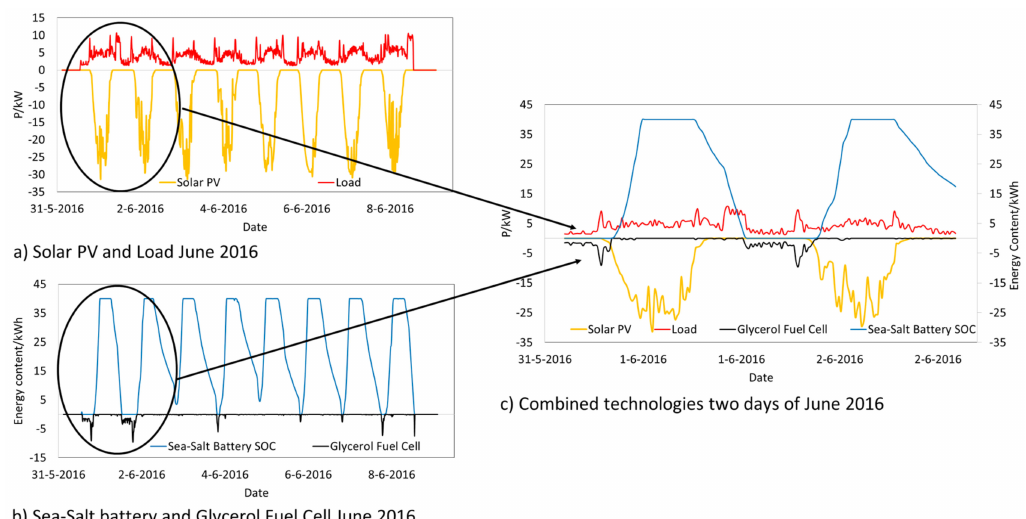
Figure 7. DEMkit results of an o ff -grid house in the Netherlands with Solar PV, Sea-Salt battery and a Glycerol Fuel Cell during one week of summer 2016 showing ( a ) Solar PV and Load, ( b ) Sea-Salt battery SoC and Glycerol Fuel cell power and ( c ) a zoom in on June 1 and 2 2016 with Solar PV, Load, Sea-Salt battery and Glycerol Fuel